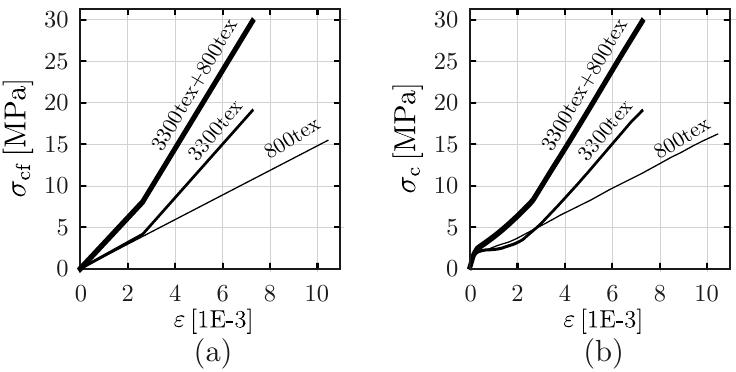
Figure 12. Reinforcement and composite stress–strain curves for cross sections with ( a ) single 800 tex and ( b ) 3300 tex reinforcements and the combined cross